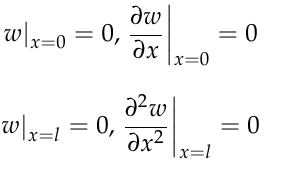
Figure 2. Variation modes for different initial conditions a ( γ π =